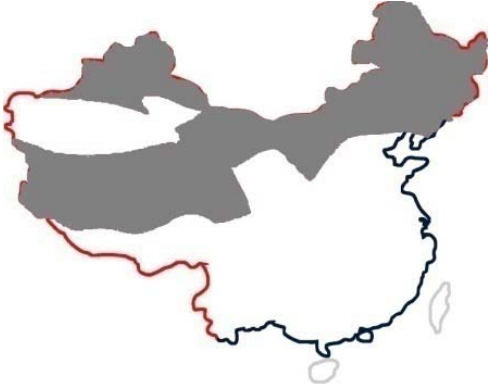
Figure 4. Severe cold region